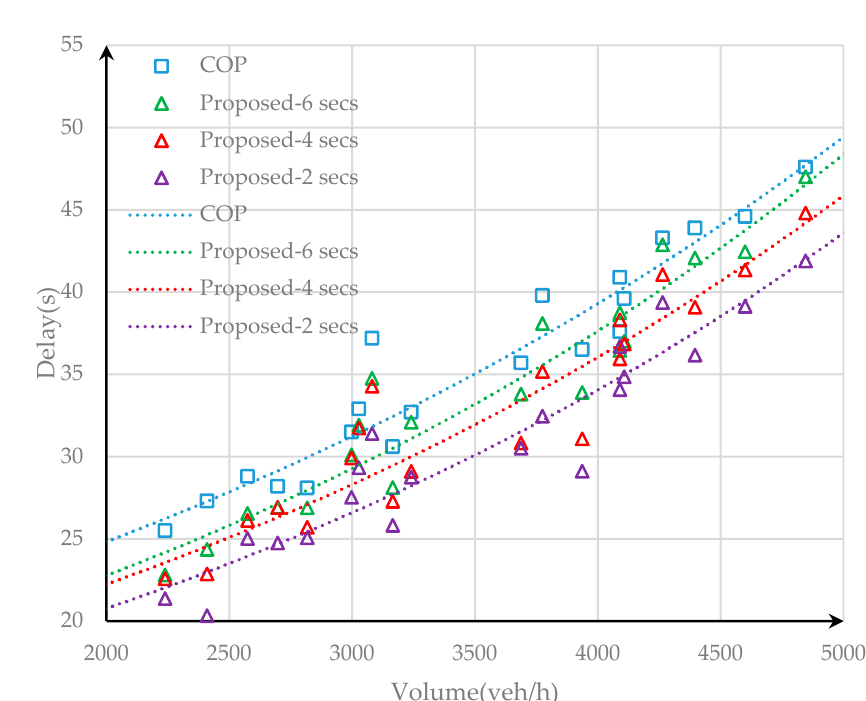
Figure 4. Diagram of the simulated road network.